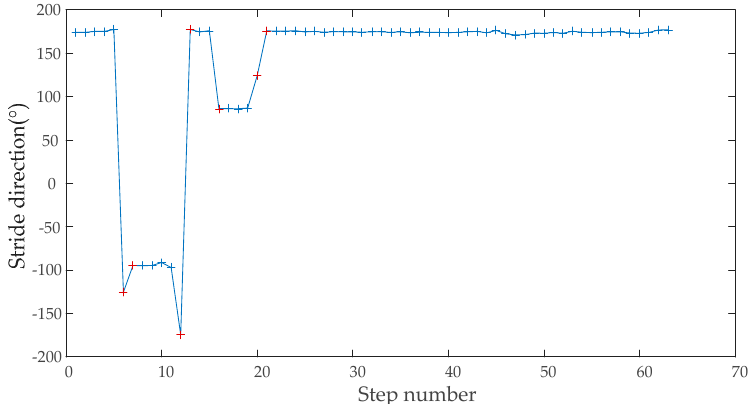
Figure 12 . The result of straight walking detection. Figure 12. The result of straight walking detection. Sensors 2019 , 18 , x FOR PEER REVIEW